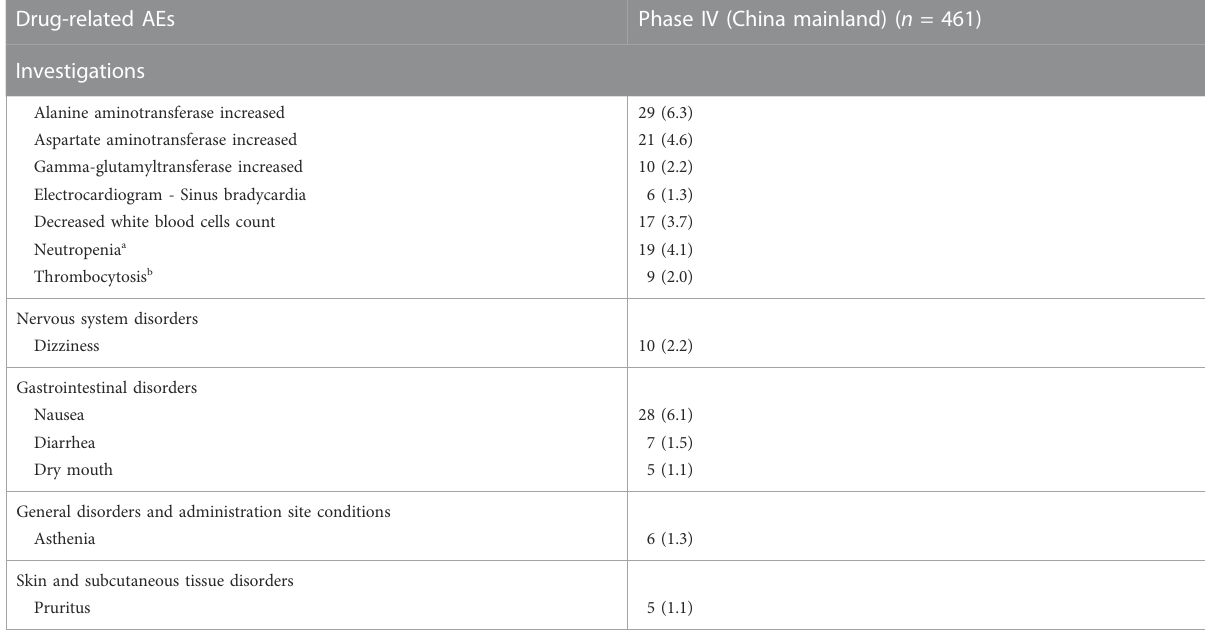
TABLE 5 Drug-related adverse events with an incidence of ≥ 1% in Phase IV studies. Drug-related